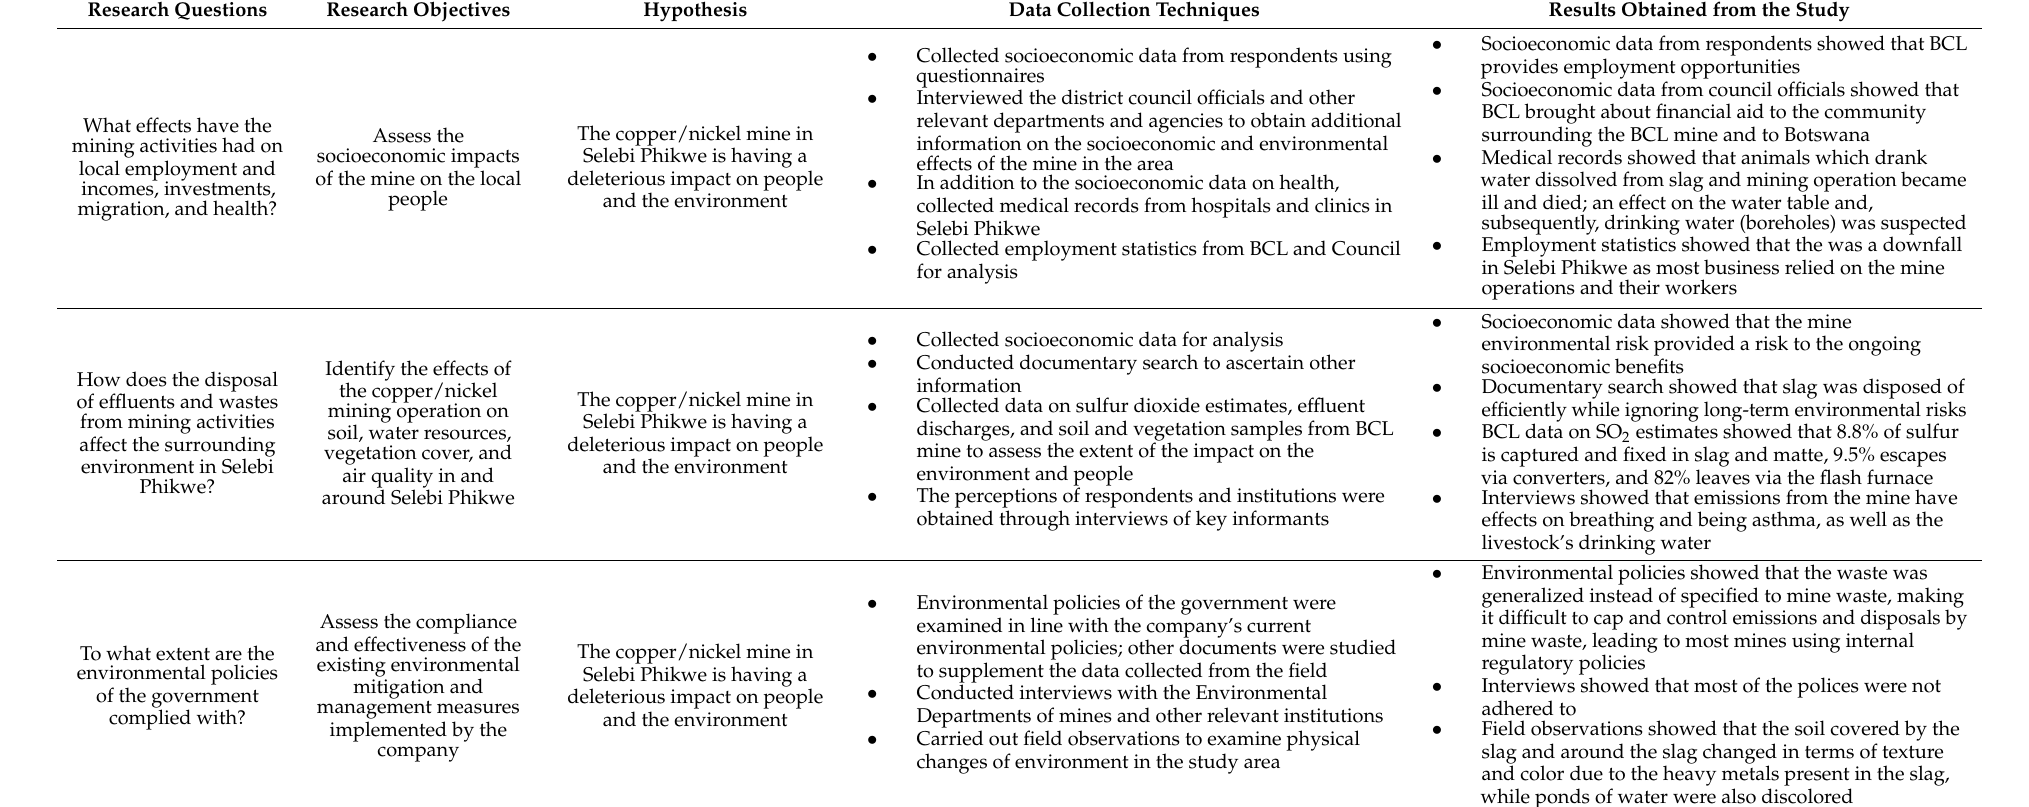
Table 2. Summary of data collected and analyzed from BCL mine